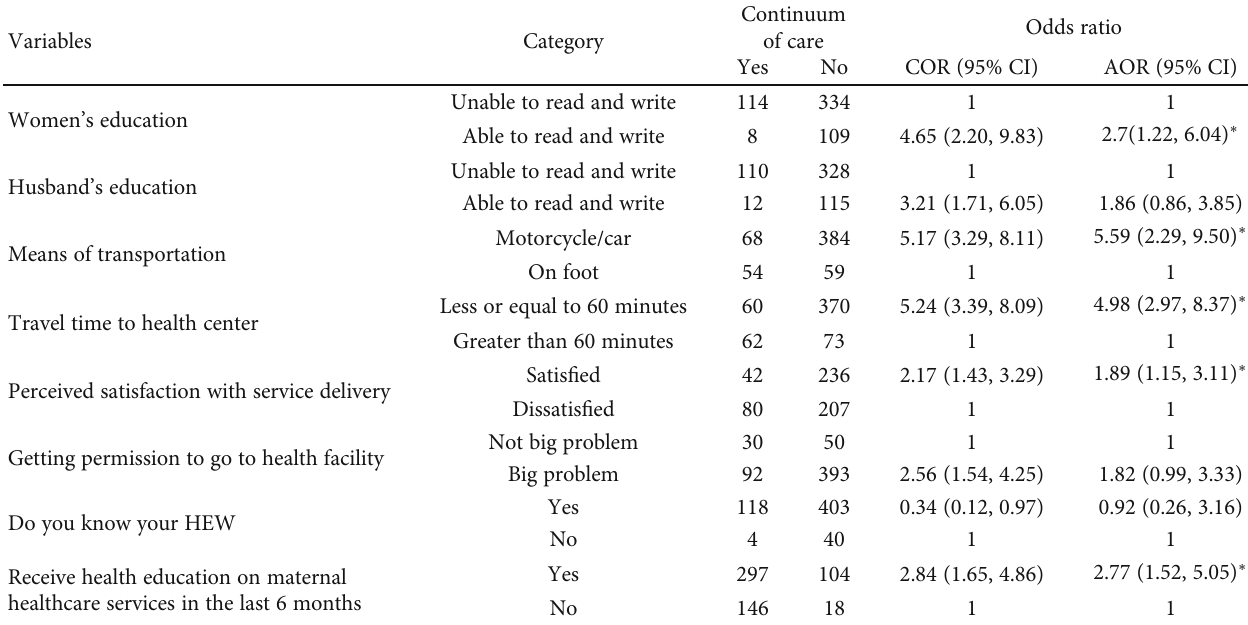
Table 2: Bivariable and multivariable logistic regression analysis of continuum of maternal healthcare services among women who give births in the last fi ve years, fi ndings from the primary health care project in northwest Ethiopian districts, September 2019 ( n = 565 ).